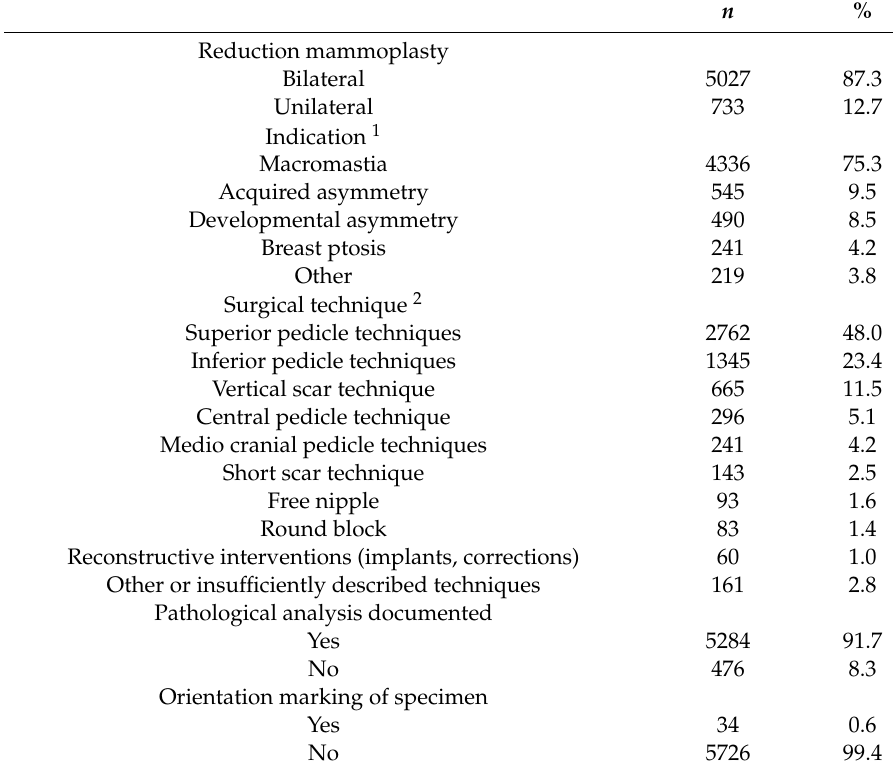
Figure 1. CONSORT diagram of the patient flow through preoperative diagnostic and surgical intervention in the study. Table 3. Details of surgical procedure and pathological workup ( n =